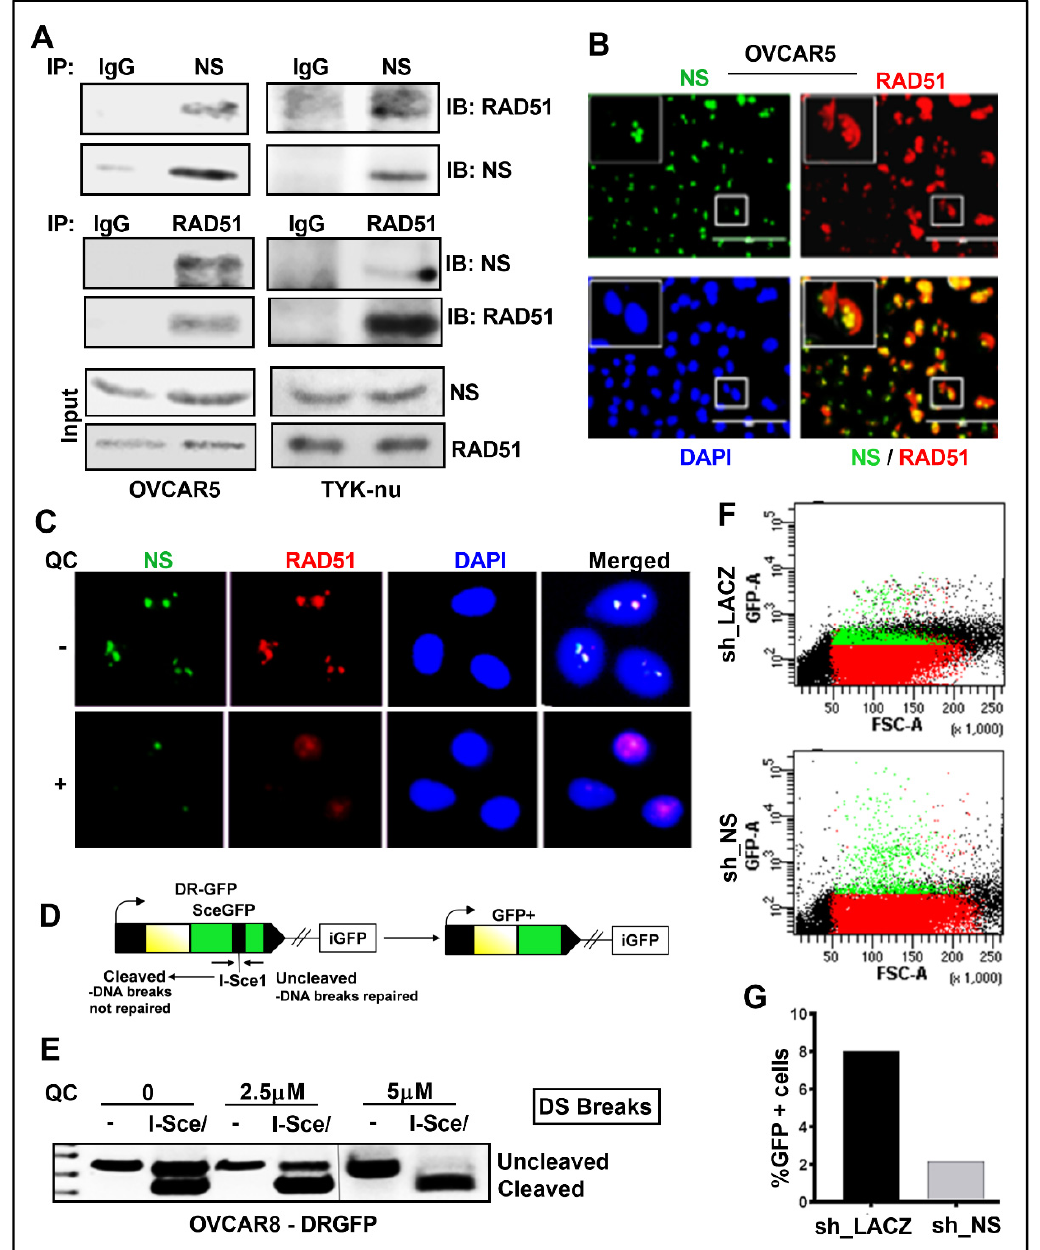
Figure 4. QC impairs the association of NS with RAD51 in OC cells. ( A ) OVCAR5 and TYK-nu cell extracts were immunoprecipitated with anti-NS and the co-precipitated RAD51 was detected by western analysis and vice versa. ( B ) IF analysis shows NS (Green) colocalizes with RAD51 (Red) (Merged image-yellow) in OVCAR5 cells. DAPI was used to stain the nuclei. ( C ) IF analysis shows that treatment with 2.5 µM QC disrupts NS (Green)–RAD51 (Red) association. DAPI was used to stain the nuclei. ( D ) PCR strategy for evaluating repair by HR. ( E ) Expression of I-SceI in OVCAR-8DR-GFP cells was performed to assess the repair of the DSB in the cells. Cells that can undergo HR repair through a short-tract gene conversion without crossing over become GFP positive. Representative gel image was shown after PCR amplification and digestion with I-SceI. ( F , G ) Repair is measured as the percentage of GFP positive cells in OVCAR-8DR-GFP cells, which is normalized to the NTC samples transfected in parallel by flow cytometry analysis. Abbreviations: QC: Quinacrine; NS: Nucleostemin, IP/IB: immunoprecipitation/immunoblot; IgG: Immunoglobulin G control; DS: double-strand break; GFP: green fluorescent protein; NTC: non-targeted control, sh_NS: shRNA-mediated NS downregulation; OVCAR8-DR-GFP: OVCAR8 cells with stable integration of pDR-GFP plasmid; I-Sce: Intron-encoded endonuclease.